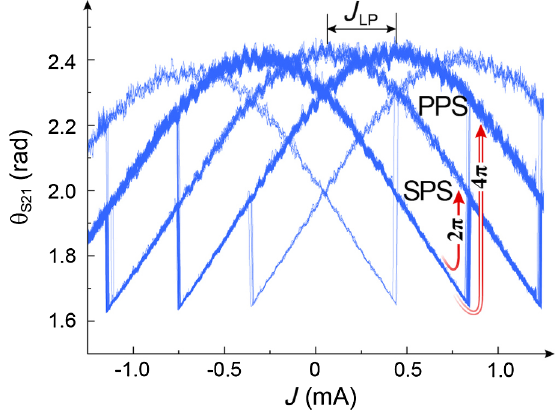
FIG. 2. Dependence of the transmission phase on the current in the solenoid. The bath temperature is 350 mK. Periodically spaced “ parabolas, ” each corresponding to a particular vorticity or the quantum winding number n , are clearly observed. SPS result in jumps of θ S 21 to the next parabola (single-line red arrow) and n → ð n (cid:2) 1 Þ change in the vorticity. PPS result in jumps of θ S 21 to the next-nearest parabolas (double-line red arrow) and n → ð n (cid:2) 2 Þ change in the vorticity. The Little-Parks period is marked as J . Regions where switching events form clusters LP correspond to magnetic fields and vorticity values at which the current in the wires is near the critical current.